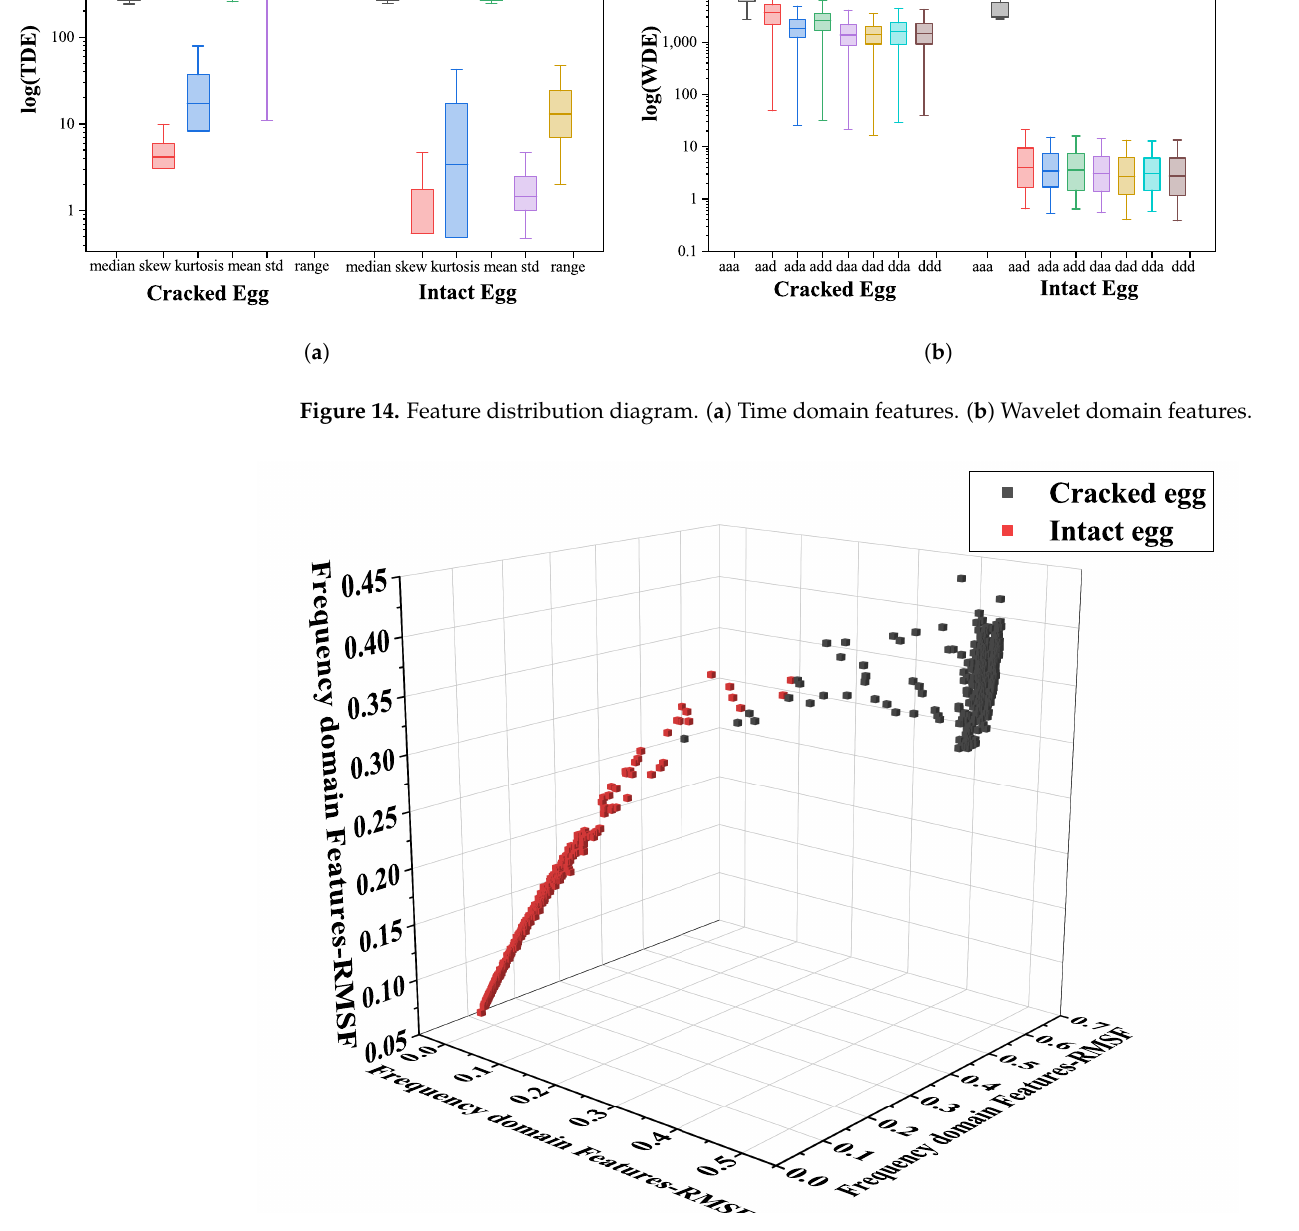
Figure 15. Three-dimensional distribution diagram of frequency domain